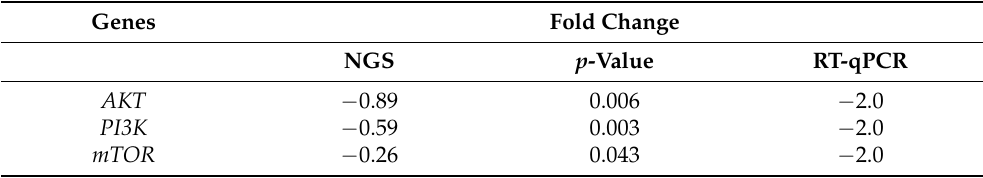
Table 5. The fold change of PI3K/AKT/mTOR genes in NGS and RT-qPCR.